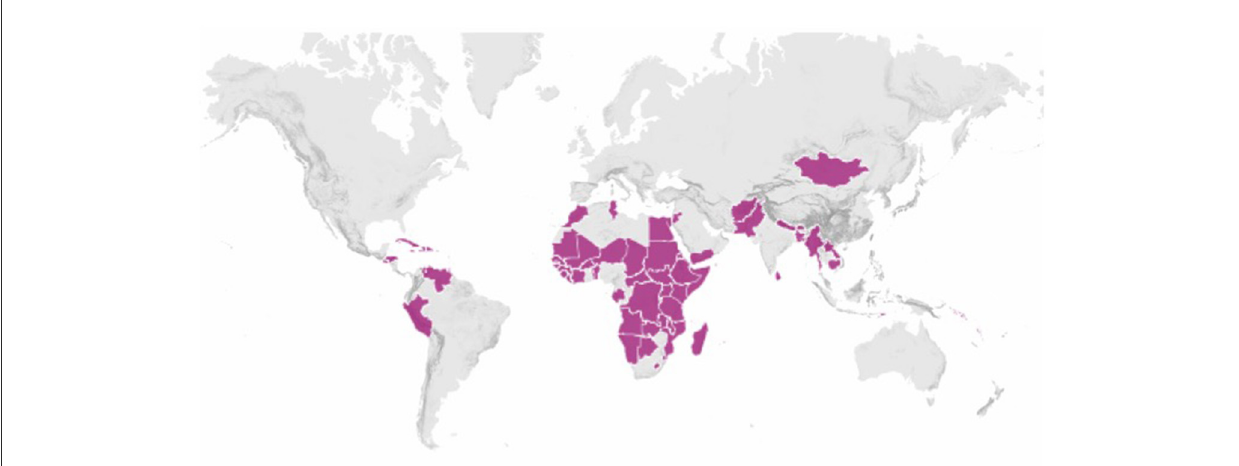
FIGURE1 Net Food Importing Developing Countries (NFIC) vulnerable to food system disruption due to exogenous events such as the Russia–Ukraine conflict including sub-Saharan Africa, South Asia, the Middle East, North Africa, Latin America and the Caribbean, and East Asia (FAO, 2022b) (Figure re-produced with permission from FAO Copyright